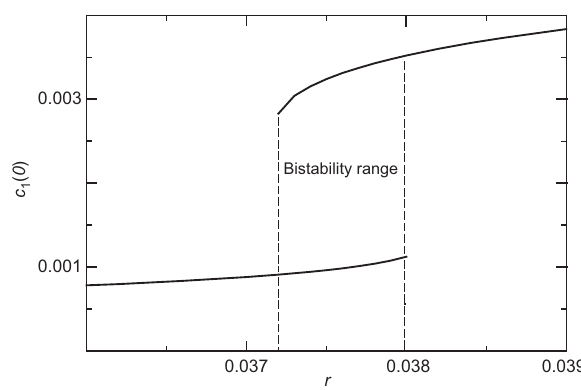
Figure 2 Bifurcation diagram showing the concentration of c the center of the bead as a function of its radius for D = 2 × 10 -5 cm 2 /s, = 3.81 × 10 -4 M , c c 10 The bistability range is between R